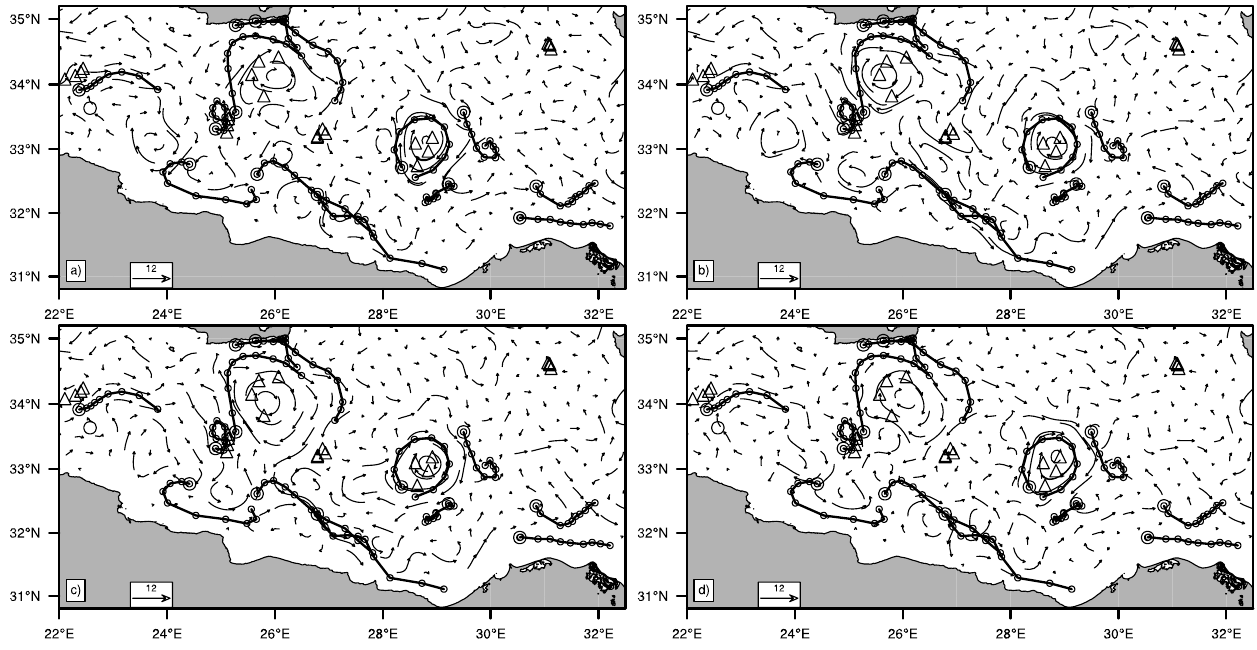
Fig. 5. Velocity vector fields at 365-m depth on 22 December 2005 from the (a) CTRL, (b) SURF, (c) SURF2, and (d) ARGO experiments. The daily observed surface drifter positions during 13–22 December are indicated by the black dots with double-circled start positions. The Argo float positions are measured every 5 days and marked for the 1-22 December period by